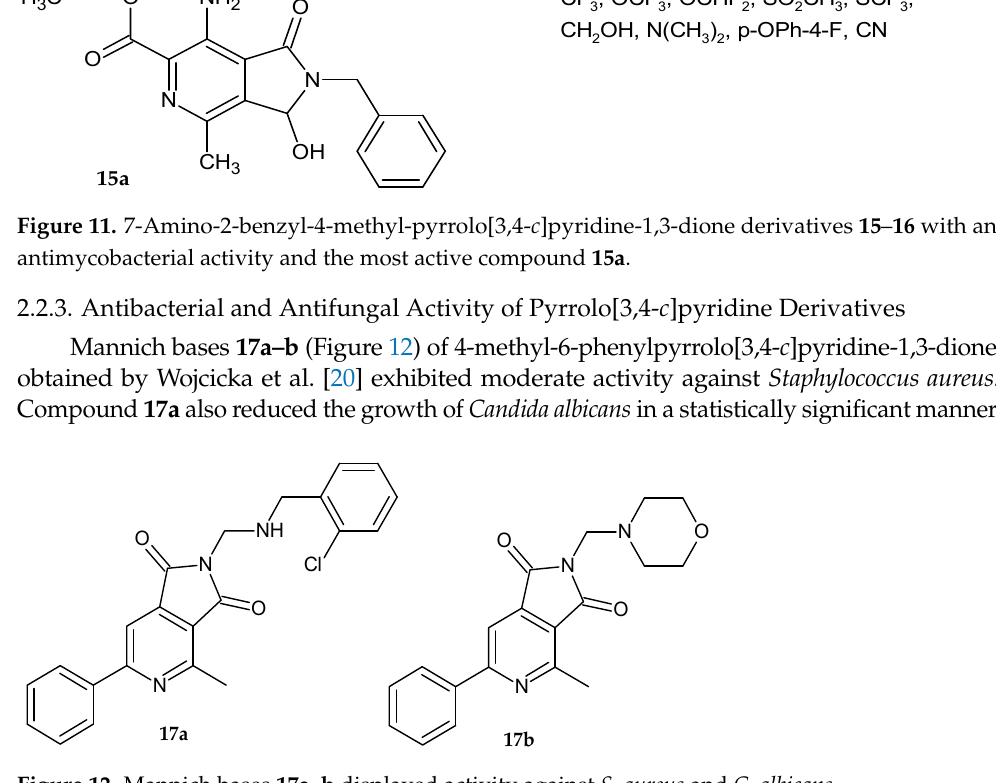
Figure 12. Mannich bases 17a ‐ b displayed activity against S. aureus and C. albicans.